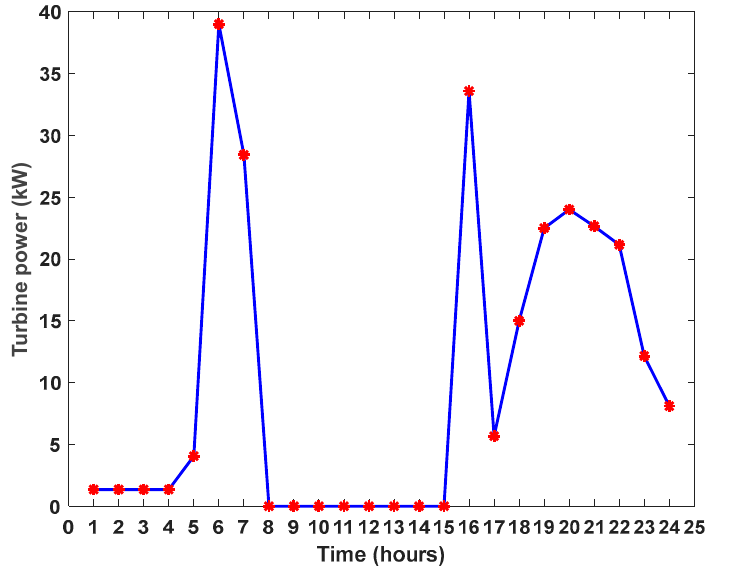
Figure 11. Turbine power profile.